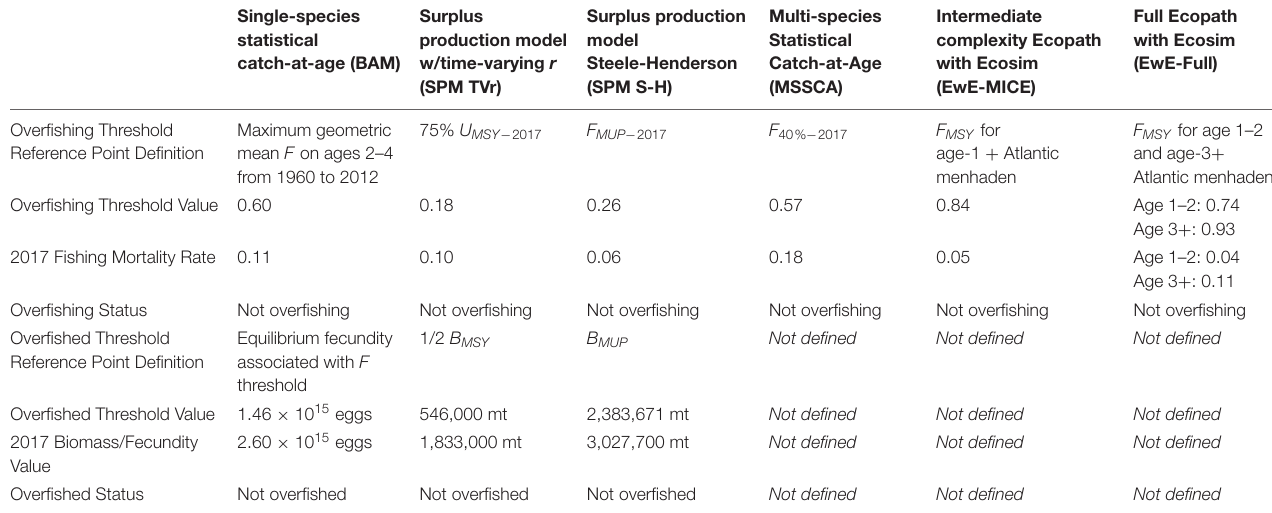
TABLE 2 | Reference points definitions and stock status determinations for the single-species and ERP models based on current ecosystem